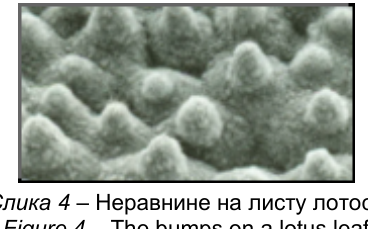
Figure 4 – The bumps on a lotus leaf Рис . 4 – Неровности на листе